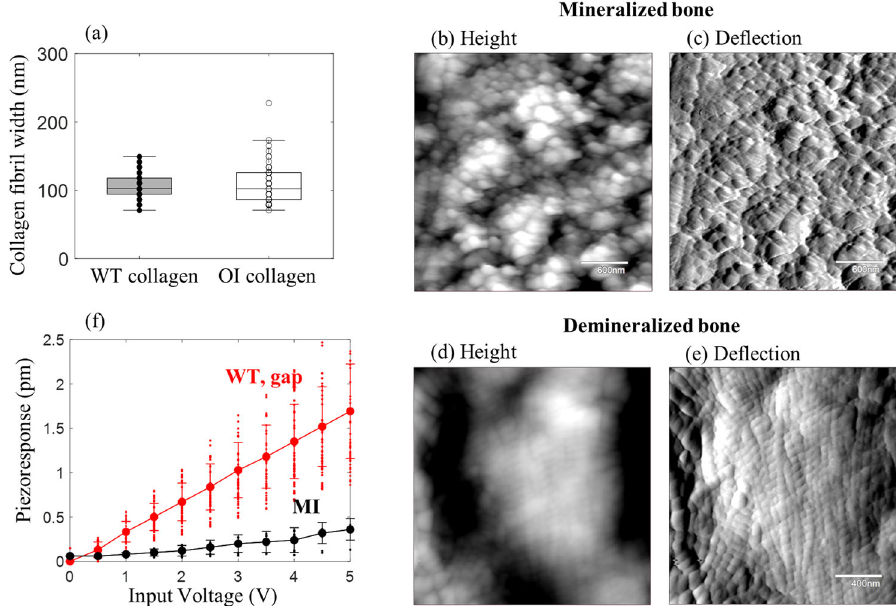
Fig. 6 Comparison between mineralized and demineralized bone surfaces. a Collagen fi bril width of WT and OI models. In total, 50 fi bril widths were investigated in each model. For WT collagen, 107 ± 19 nm width was observed, while 109 ± 31 nm width was observed for OI collagen. There was not a signi fi cant difference observed between WT and OI collagen width, as p -value was greater than 0.05 based on t-test analysis. b Height and c de fl ection maps of mineralized bone surface and d height and e de fl ection maps of the demineralized bone surface, respectively. f PFM results for mineralized (MI, black) and demineralized (WT, blue) bone surfaces. When compared to the collagen piezoresponse, the mineralized bone surface exhibited a very weak piezoelectric